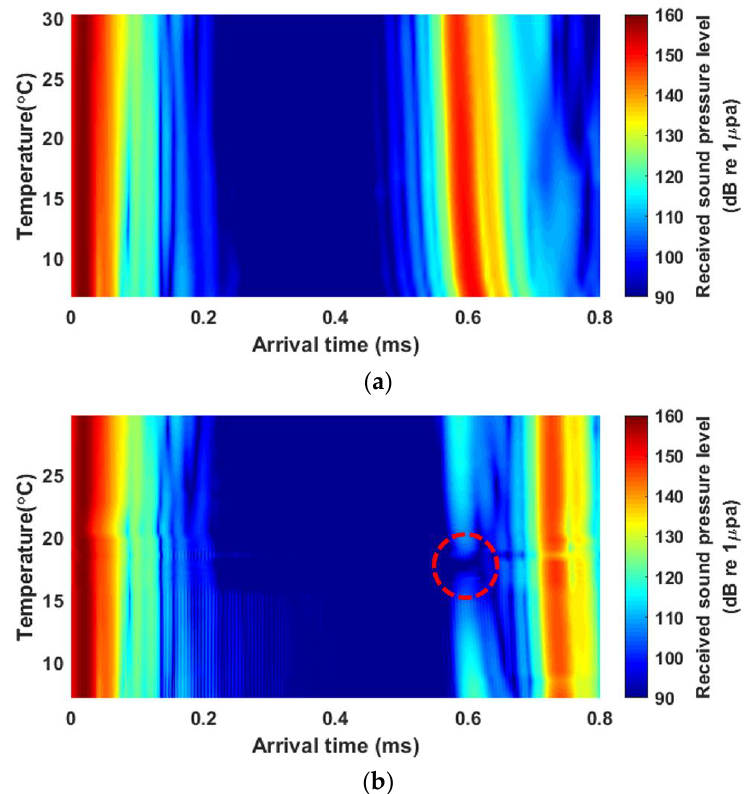
Figure 5. Received sound pressure levels as functions of temperature and arrival time for ( a ) a water-air interface and ( b ) a water-castor oil interface. The average intensities of 10 pings for each temperature step were interpolated. For the water-air interface and the water-castor oil interface, nine and thirty-four datasets, respectively, were used for the interpolation. The red circle in ( b ) highlights where the total transmission into the castor oil layer occurred. The temperature of this part corresponds to the temperature of intromission.